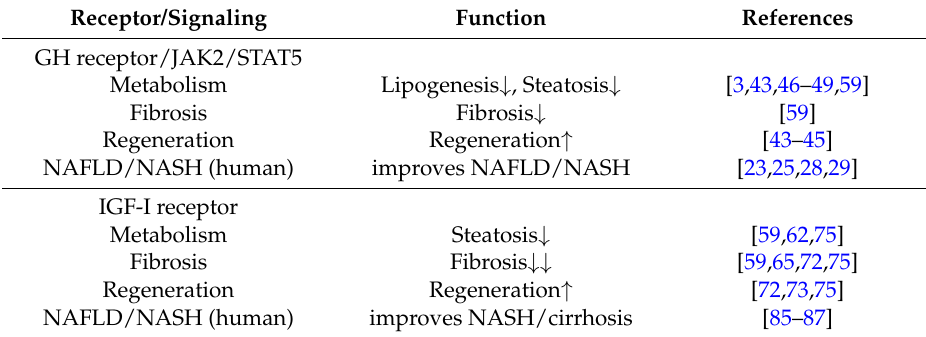
Table 1. The role of growth hormone (GH) and insulin-like growth factor-I (IGF-I) signaling in the